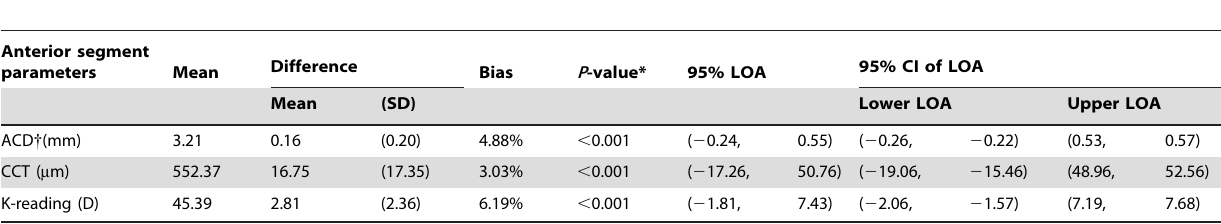
Table 2. Comparison of anterior segment parameters measured by anterior segment optical coherence tomography and various modalities.